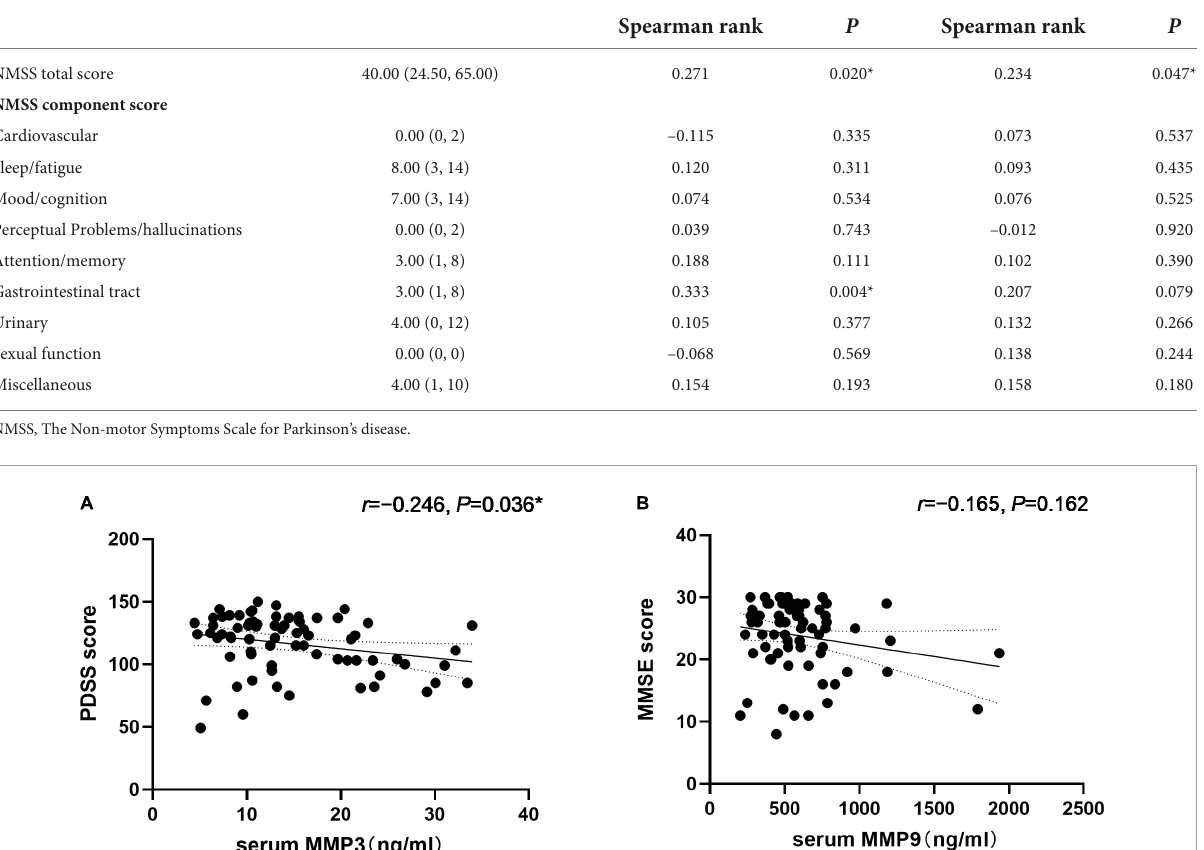
TABLE 2 Correlation analysis of non-motor symptoms and serum MMP3 and MMP9 levels in PD patients. Medians (quartile ranges)